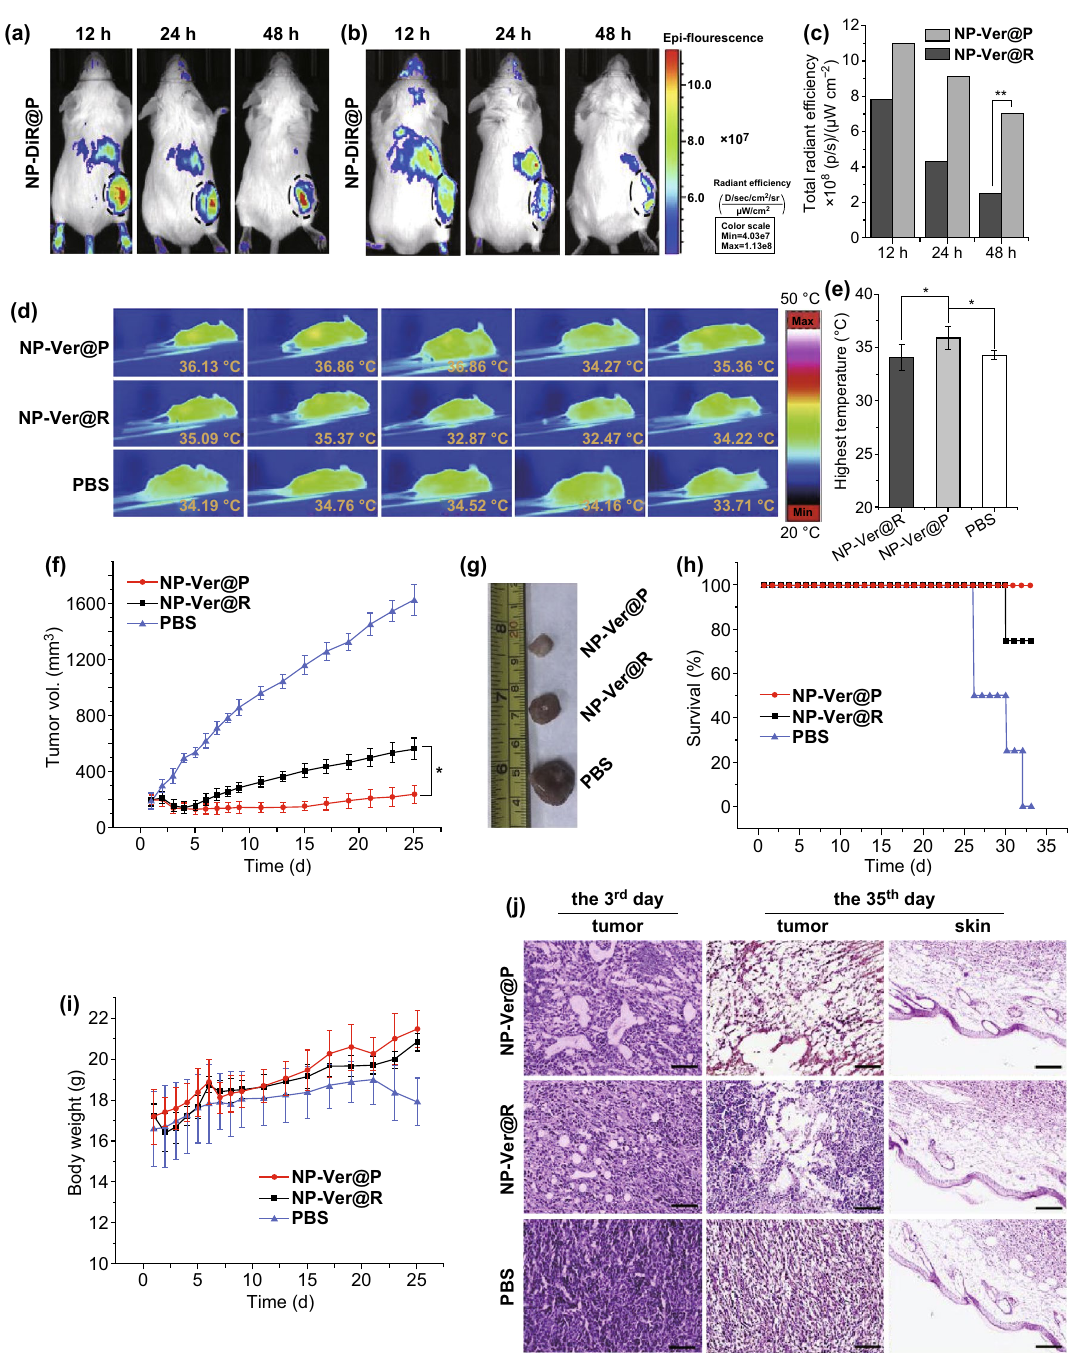
Fig. 7 Mice received an i.v. injection of NPs, and after 12, 24, and 48 h, tumors and organs of random mice were isolated and used to assess fluorescence and verteporfin levels therein following homogenization. a – c In vivo fluorescence images of mice implanted with 4T1 tumors 12, 24, and 48 h following injection of a PNPs and b RBC‑coated NPs loaded with the red membrane dye DiR, with black circled dots identifying tumors. c Total radiant efficiency in tumors was determined based on the images from a and b . d Mice ( n = 5/group) were irradiated with 680– 730 nm light (0.05 W cm −2 ) for 10 min, 24 h after administration of PBS or of PNPs or RBC‑coated NPs loaded with verteporfin. e Quantifica‑ tion of average tumor center temperatures from d . Data are mean ± S.D. f Average tumor volume in mice following light irradiation. g Tumors were excised from treated mice 35 days following NP administration. h Mouse survival and i average body weight of differently treated mice following light irradiation. Mice treated using RBC‑coated NPs loaded with verteporfin are included for reference, as are PBS‑injected controls. Data are mean ± standard deviation. j Tumor and skin sections stained with H&E on days 3 and 35 after NP administration. Scale bar = 50 µm. *p < 0.05 and **p < 0.01. Adapted from Ref. [114] with